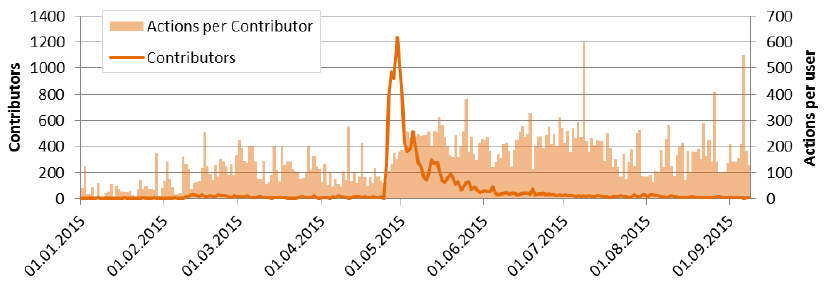
Figure 6. Number of daily contributors and actions per contributor in Nepal before and after the earthquake in April 2015 for all 26 feature types as described above.